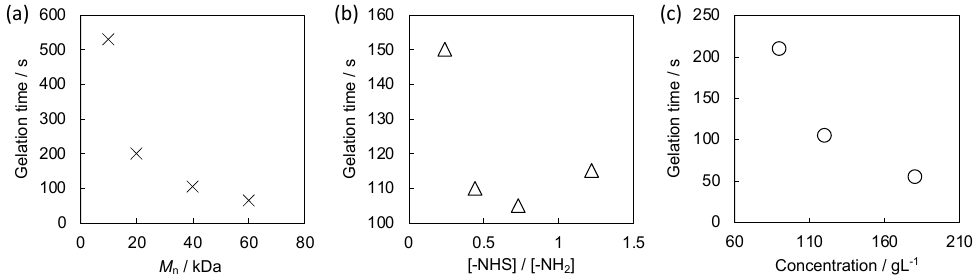
Figure 5. The dependence of the gelation time on ( a ) molecular weight of the polymeric crosslinkers, ( b ) [ − NHS]/[ − NH 2 ] ratio and ( c ) concentration of pre-gel solution.